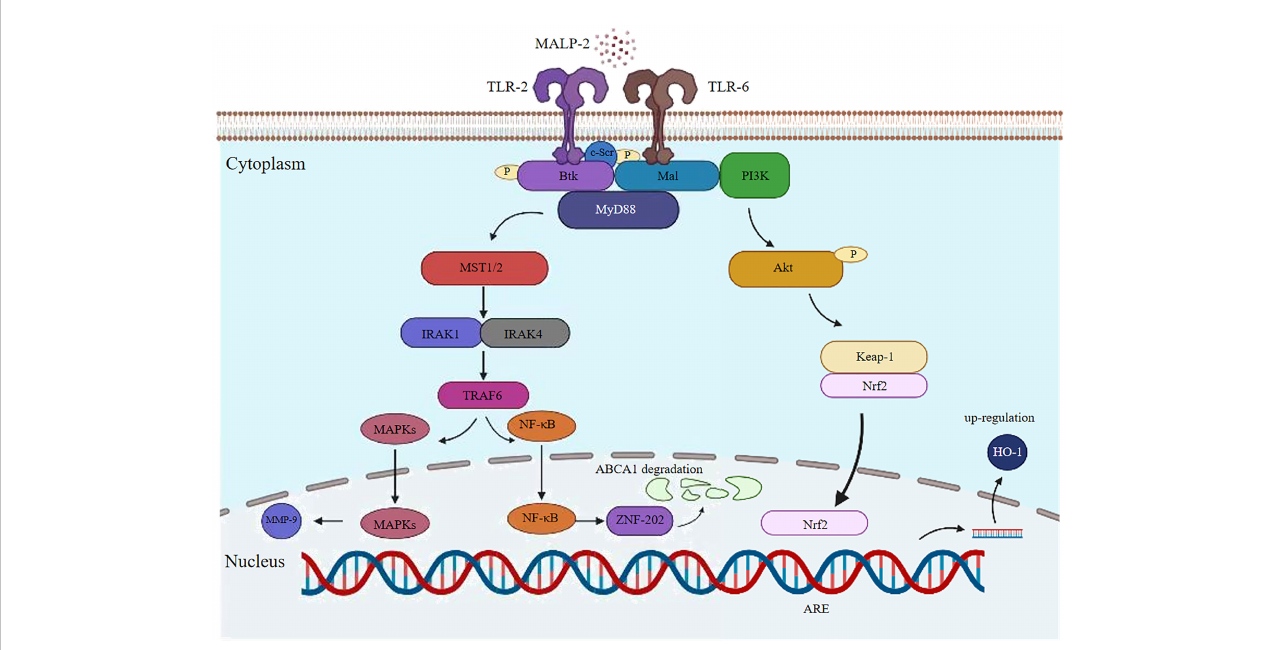
FIGURE 2 Potential signaling pathway induced by MALP-2 in THP1 cells. MALP-2 induces MMP-9 expression in THP-1 cells via the MAPKs pathway; MALP-2 can decrease ABCA1 expression and subsequent cholesterol ef fl ux through activation of the TLR2/NF- k B/ZNF202 signaling pathway in THP-1 macrophages; The cytoplasmic adaptor Mal recruits the TLR2/6 heterodimer in response to MALP-2 stimulation. c-Src, Btk, Mal and MyD88 form a physical complex to activate PI3K, which further induces Nrf2 translocation to the nucleus and binds to the ARE-site to stimulate HO-1